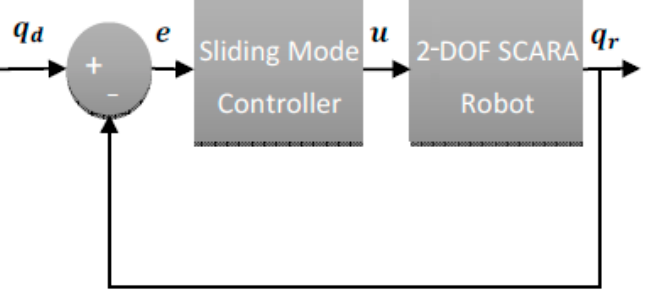
Figure 2. Sliding mode controller for a two-DOF SCARA robot.